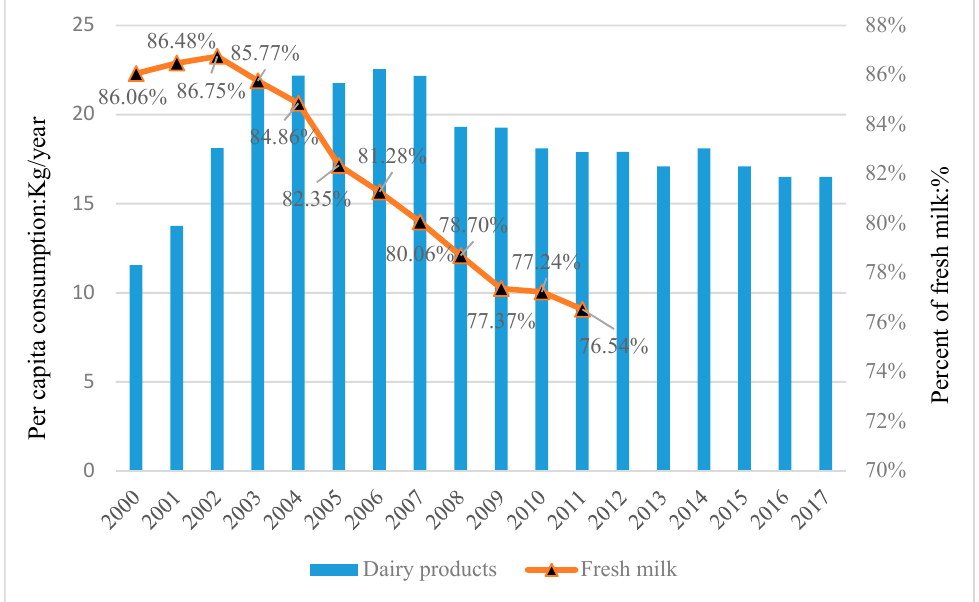
Figure 1. Chinese urban consumers’ per capita dairy consumption. Data Source: China Dairy Yearbook, 2000–2017. Note: Dairy products include fresh milk, milk powder, and yogurt.